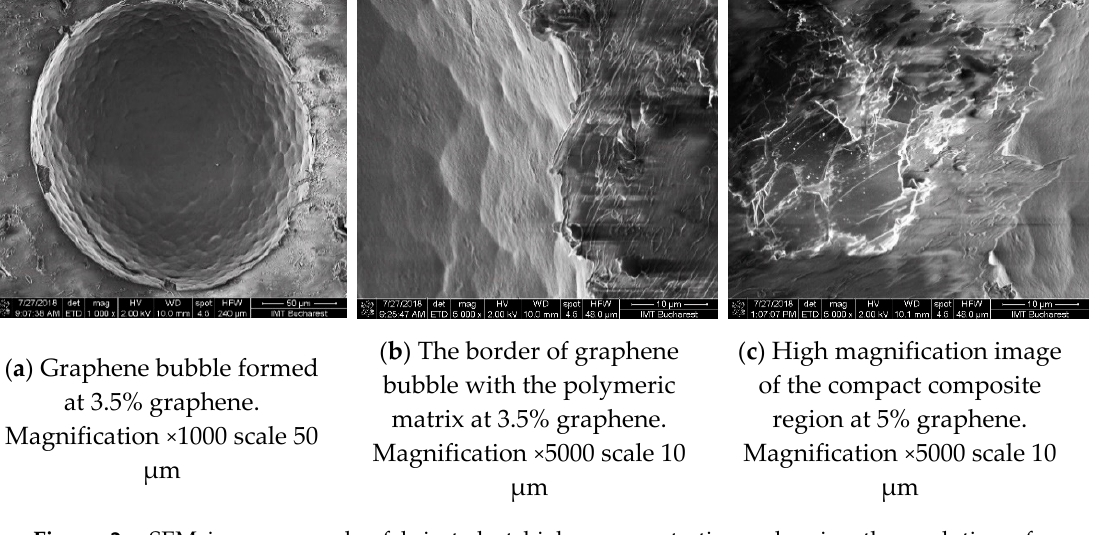
Figure 2. SEM images samples fabricated at higher concentrations, showing the evolution of materials morphology.